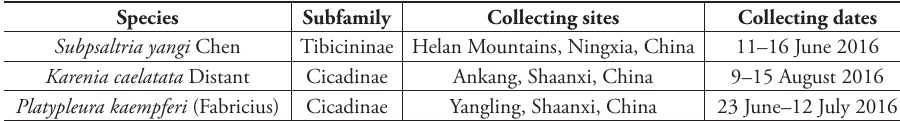
Table 1. Taxonomic status and collecting information of three investigated species. Species Subfamily Collecting sites Collecting